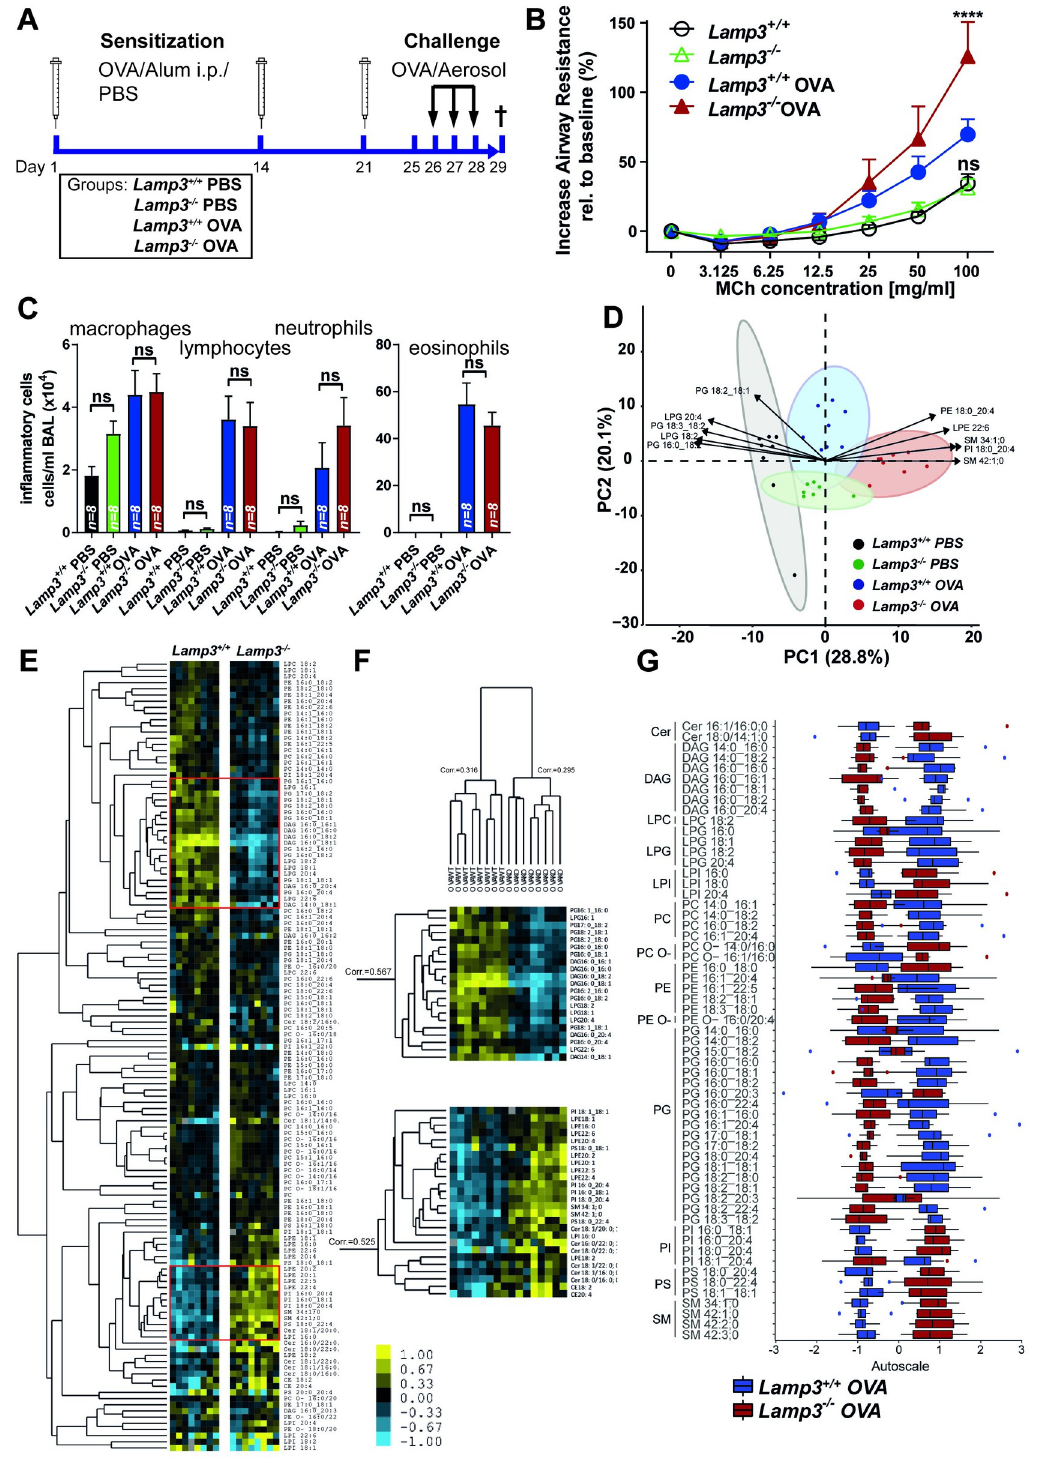
Fig 5. The allergen-induced asthma model aggravates phenotypes in Lamp3 -/- mice and causes a genotype-dependent increase in airway resistance. (A) Experimental setup of the stress-challenged model of allergic asthma and the experimental groups. (B) Number of inflammatory cells in the BAL of wildtype, Lamp3 -/- , wildtype + OVA, Lamp3 -/- +OVA mice. N = 8 (per genotype), ns = not significant; 0.05; � = p � 0.05. (C) Increase in airway resistance relative to baseline (%) of the